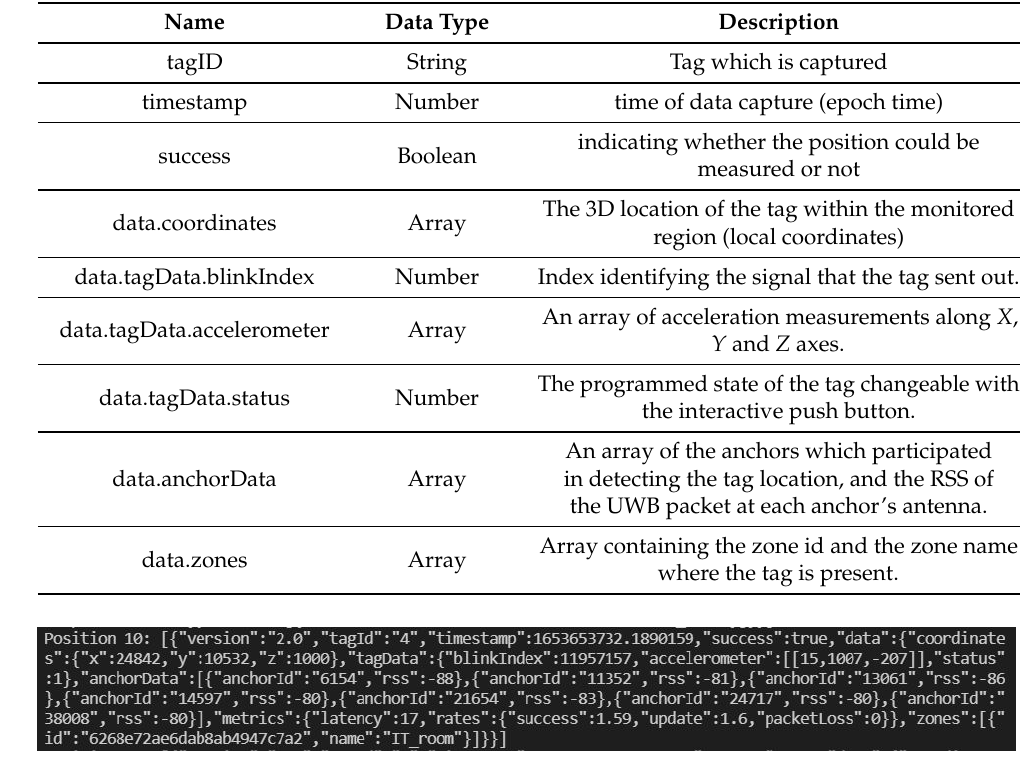
Figure 4. JSON Message carrying tag